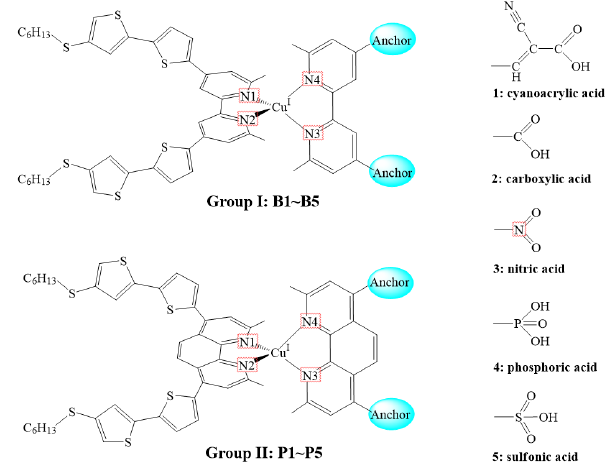
Figure 1. Molecular structures of B1–B5 and